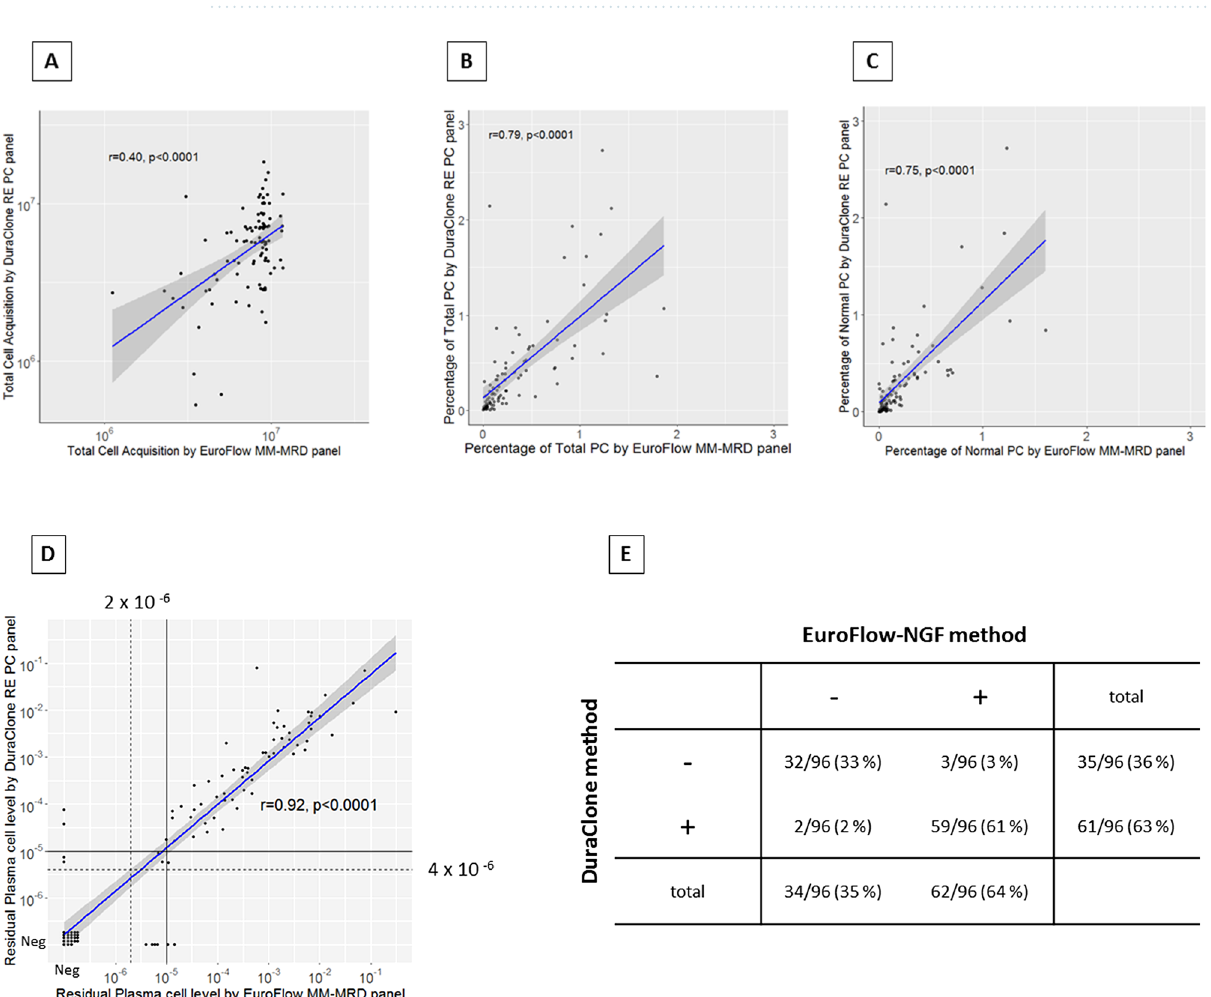
Figure 4. Comparison between the DuraClone and EuroFlow-NGF methods. Total cell acquisition ( A ), percentages of total plasma cells (PCs) ( B ) and normal PCs ( C ), quantitative study of minimal residual disease (MRD) detection ( D ), and qualitative study of MRD detection ( E